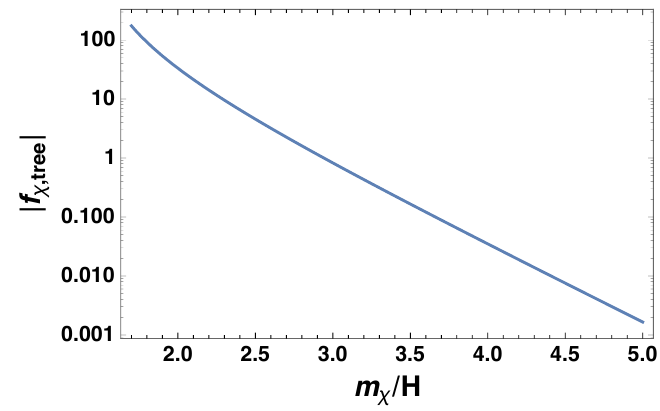
Figure 4 . The strength of NG for tree level Higgs exchange as a function of Higgs mass m (cid:31) for (cid:26) 2 = 0 : 3 H and _ (cid:27) 0 = (cid:0) H 2 . The function j f (cid:31); tree ( (cid:22) ) j is de(cid:12)ned in eq.